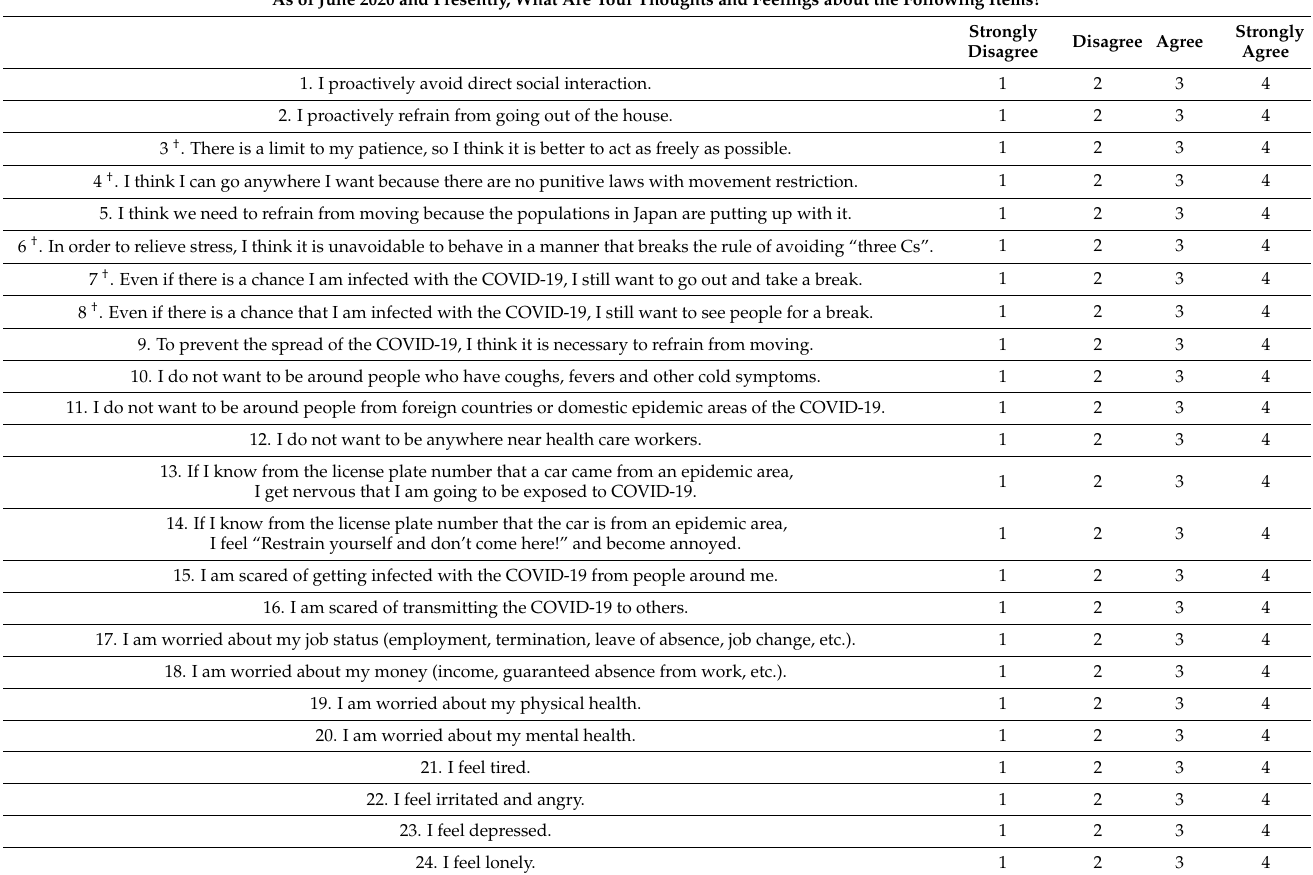
Table 1. Questions about self-restraint behavior (SRB) and COVID-19-related factors. (The Following Instructions and Sentences Were Shown to the Respondents.) How Much Has the COVID-19 Pandemic Affected Your Daily Life? As of June 2020 and Presently, What Are Your Thoughts and Feelings about the Following Items?